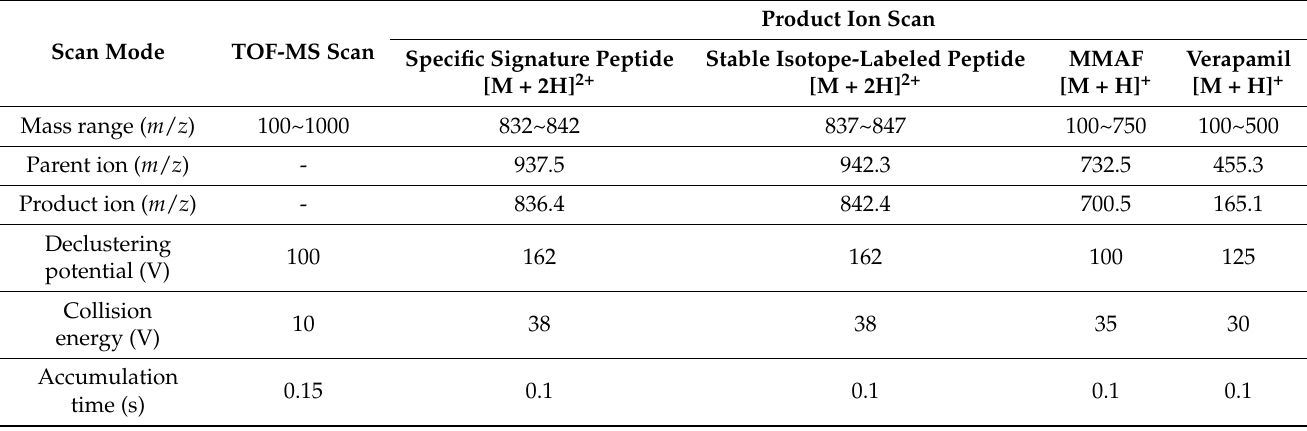
Table 1. The mass spectrometric conditions for quantification.